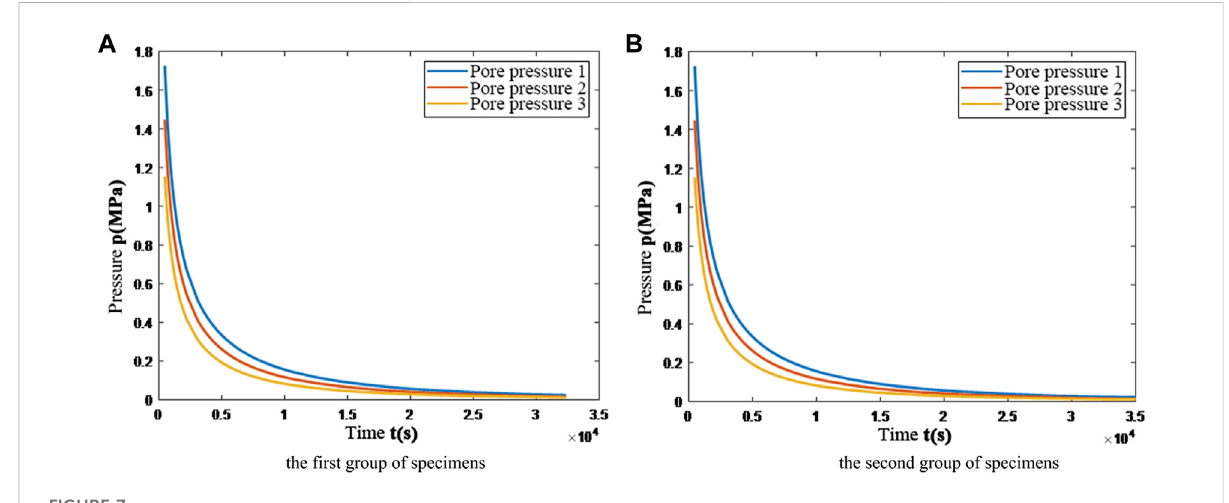
FIGURE 7 Curve of the pore pressure over time.